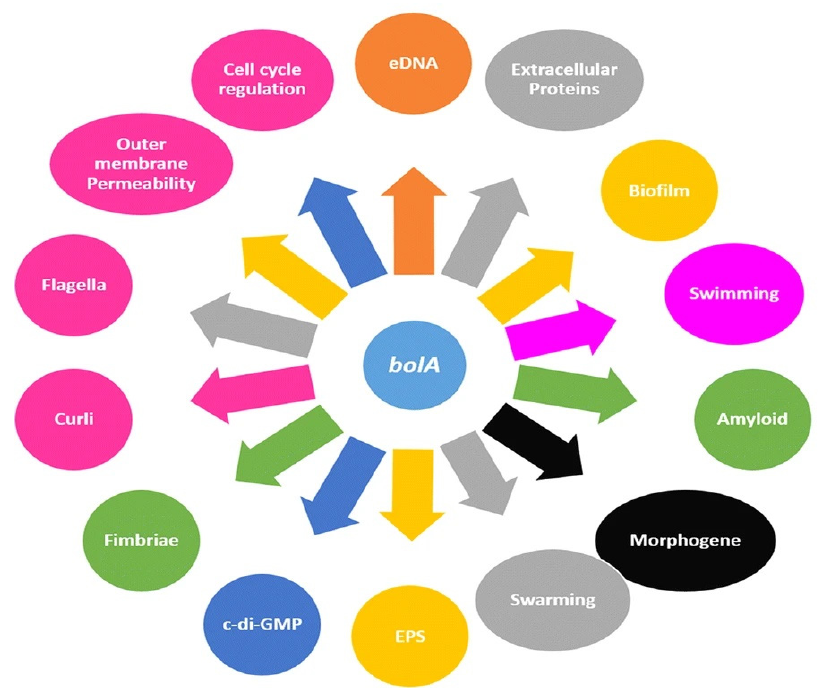
Figure 1. Cellular mechanisms in E. coli connected to the bolA gene/BolA protein (Reprinted from an open-access source) [45].